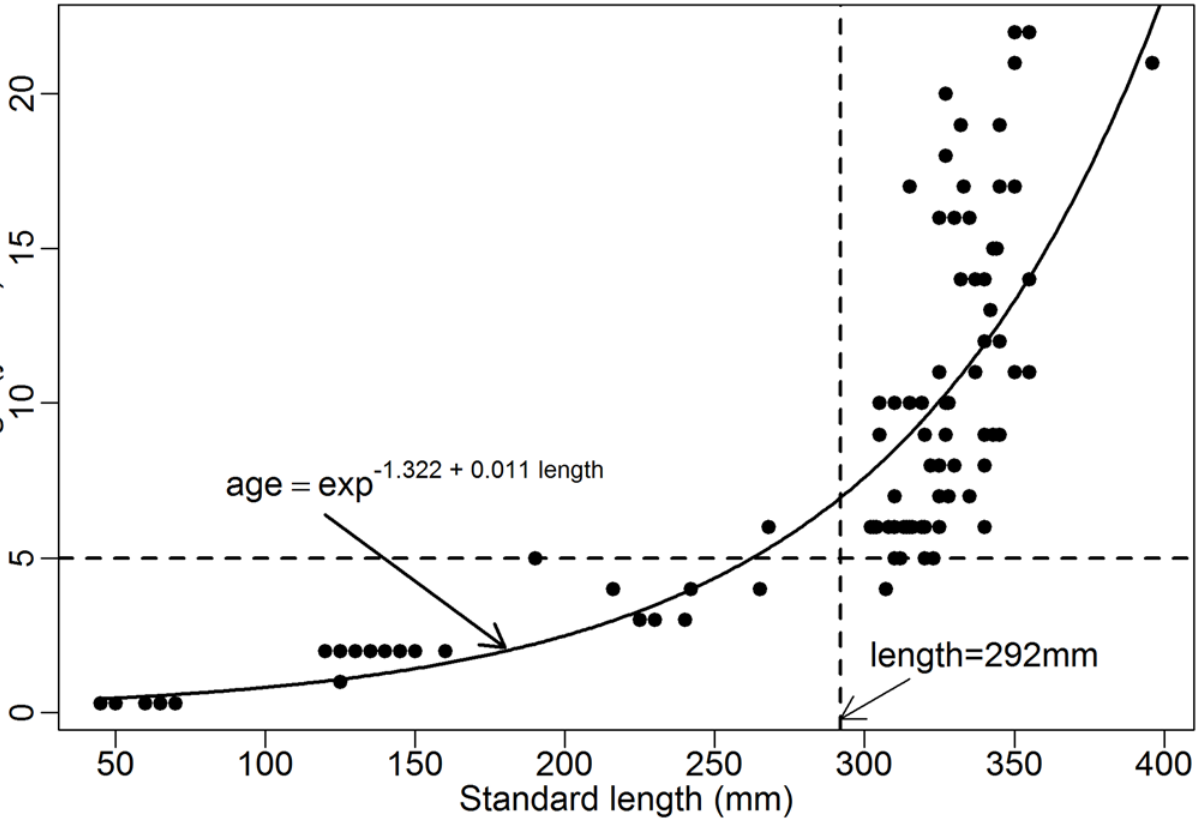
Fig 4. Bream length-age relationship in the Ř ímov Reservoir, 2012. Vertical and horizontal lines indicate standard length of 292mm and age of five years, respectively, the threshold length and age above which bream is underrepresented in ESG catch.